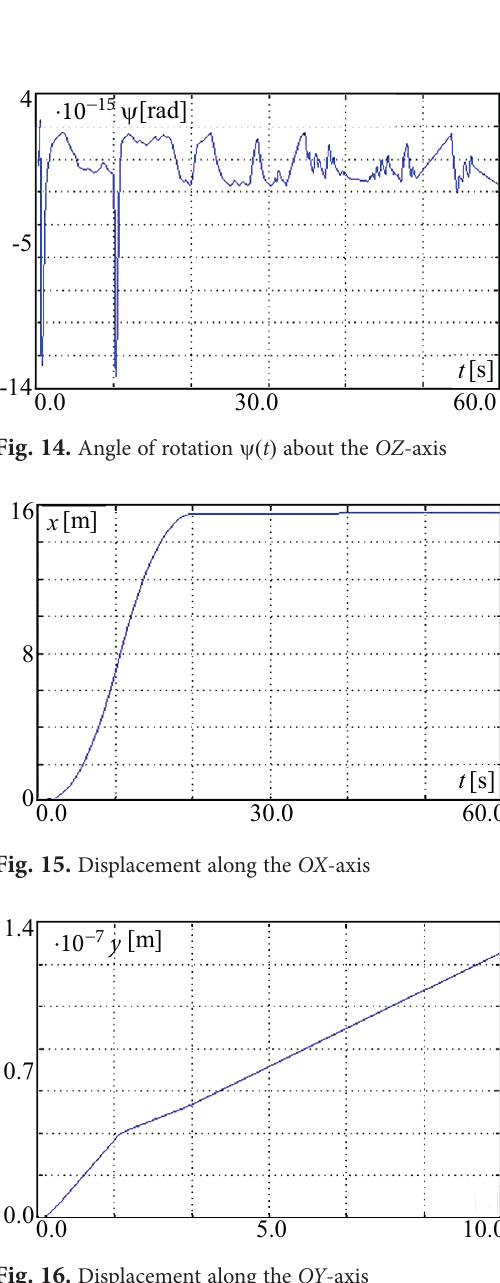
Fig. 16. Displacement along the OY -axis